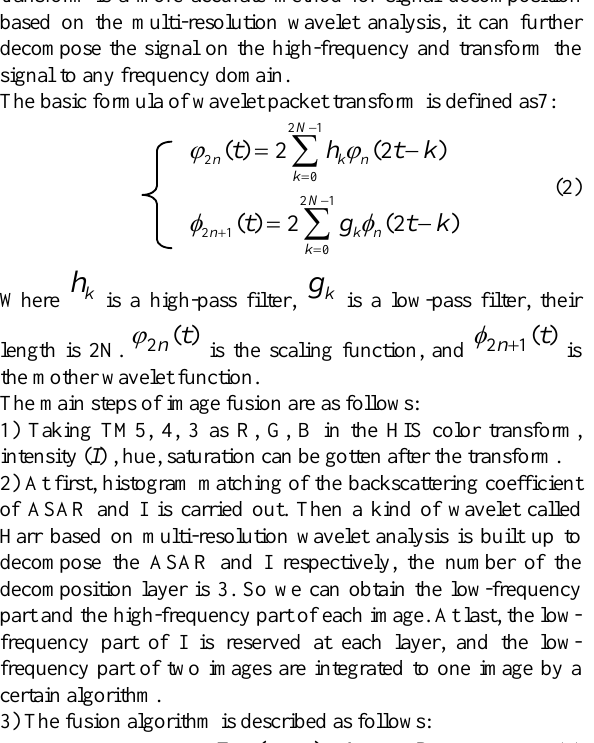
Figure 1(a) the false color composite image